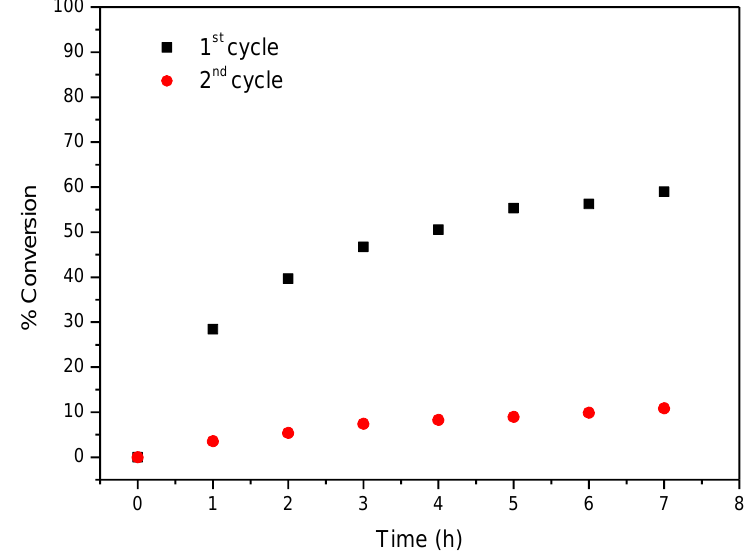
Figure 13. Oxidation of cyclooctene using CAT-4-MR as catalyst and diluted (1:5) H 2 O 2 as oxidant with additions of 0.5 eq. every 15 min.